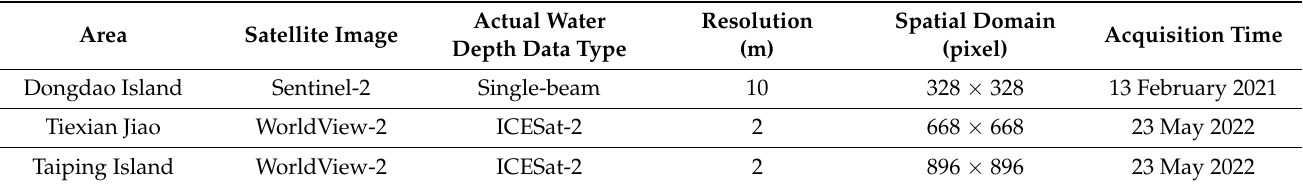
Figure 1. The satellite images of study areas and the distribution of actual water depth points. ( A ) Dongdao Island; ( B ) Tiexian Jiao; ( C ) Taiping Island. Table 1. Basic attributes of remote sensing images. Table 1. Basic attributes of remote sensing